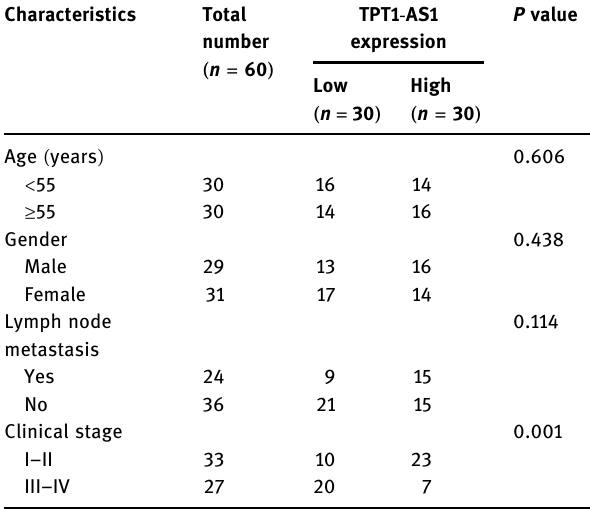
Table 1: Association between TPT1 - AS1 expression and clinico - pathological features of ESCC patients